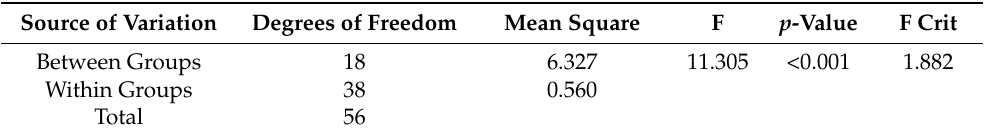
Table 6. Analysis of variance of total aflatoxins content in a panel of 19 mushroom-based supplements between the mean values determined on 3 different